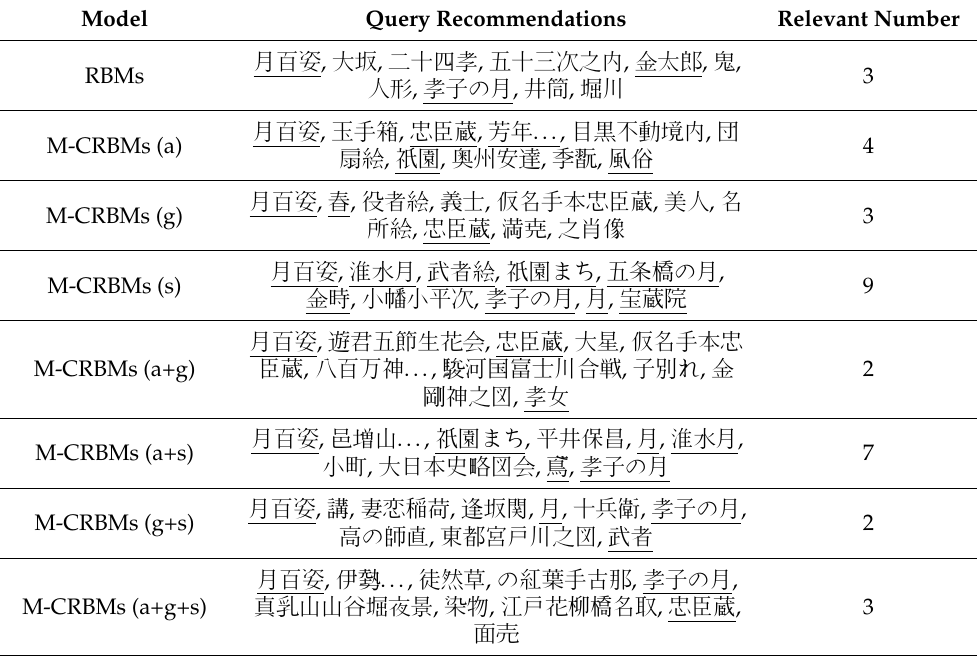
Table 2. Top 10 recommended queries for each model given the input query “ 月 百 姿 ”. The counts of the relevant recommended queries are shown in the relevant number column, and the underlined queries are the relevant ones. Model Query Recommendations Relevant